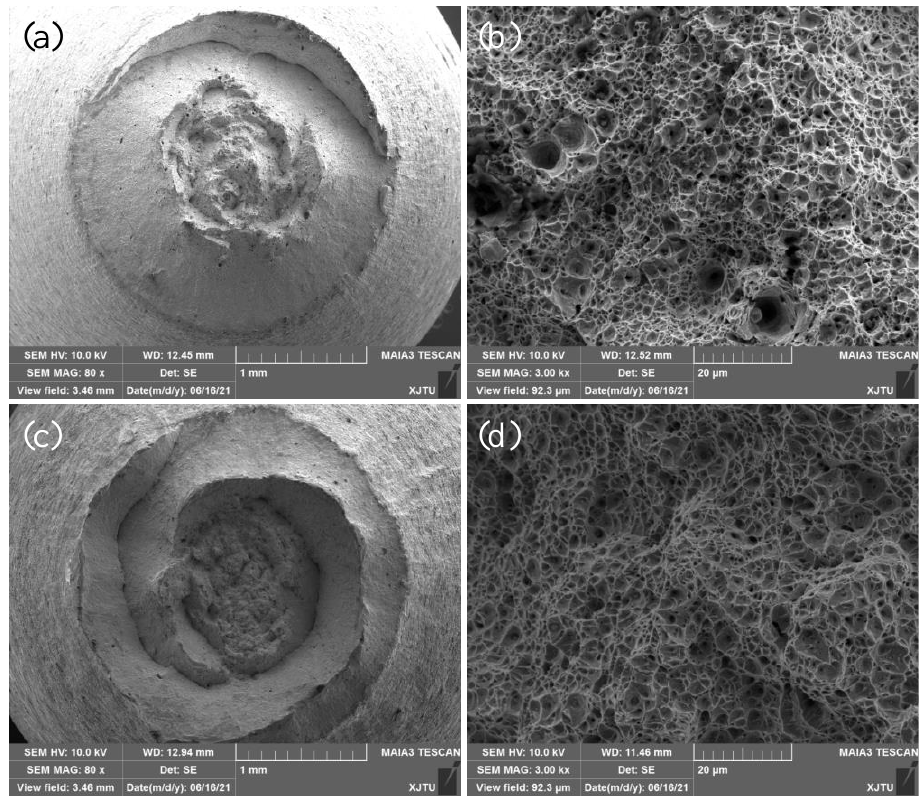
Figure 5. SEM images showing tensile fracture surfaces of ( a , b ) BM and ( c , d ) WM specimens at 350 °C.